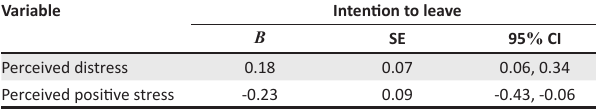
TABLE 4 : Indirect effects of stress on intention to leave via flourishing. Variable